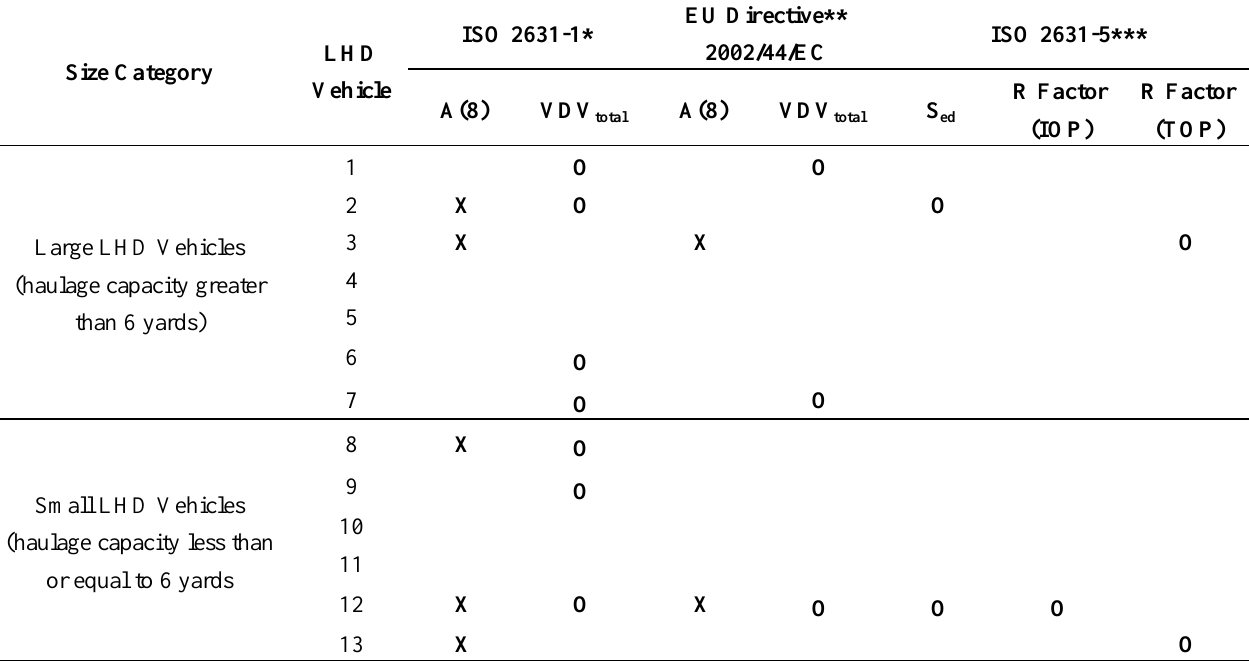
Table 6. Summary: Probability of health risk based on ISO 2631-1, EU Directive 2002/EC/44 and ISO 2631-5 criterion values. “O” is used to compare measures evaluating vibration exposure with impact shocks and “X” is used to compare A(8)